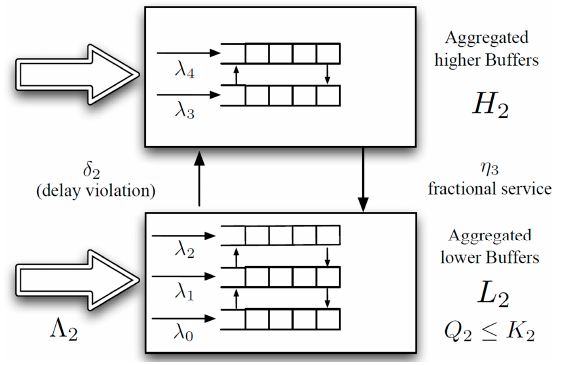
Figure 8. Buffer aggregation for M = 4.